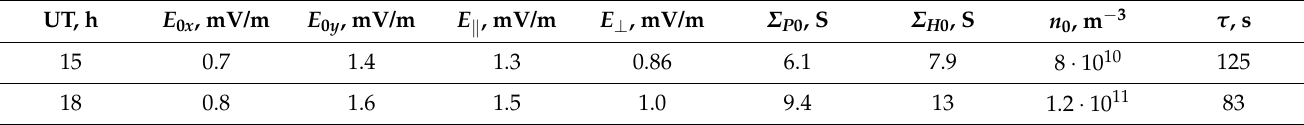
Figure 4. Spatial distribution of the electric field amplitude and its vectors (black arrows) in the lower ionosphere. The red vertical line shows the position of the subsolar meridian. ionosphere. The red vertical line shows the position of the subsolar meridian. Table 1. Environmental parameters for 15:00 UT and 18:00 UT. Table 1. Environmental parameters for 15:00 UT and 18:00 UT